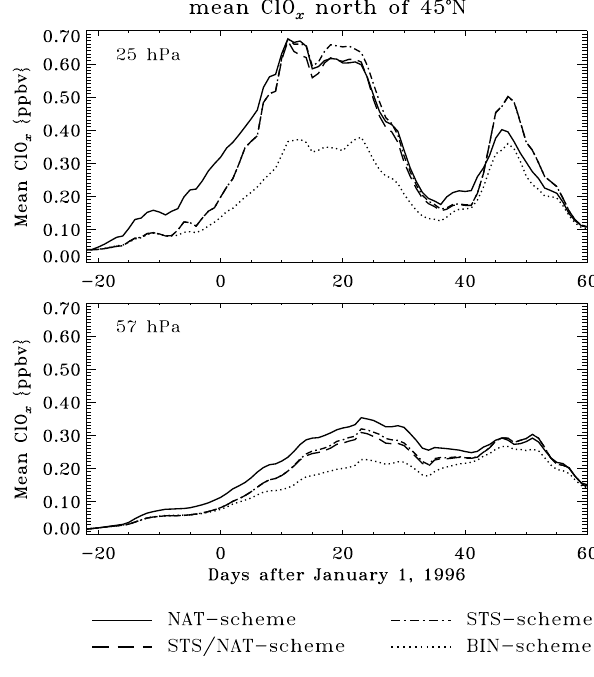
Fig. 5. Temporal change of the ClO mixing ratio (ppbv) averaged over the area between 45 ◦ N and 80 ◦ N. Model results are shown as obtained with the COMMA model applying the NAT-, the STS- and the STS/NAT-scheme, respectively. For comparison, correspond- ing average ClO concentrations derived from UARS-MLS observa- tional data as well as the potential MLS ClO errors are presented. Data is shown for the model levels (bottom frame) 57 hPa and (top frame) 25 hPa and the time period between 10 December 1995, and 29 February 1996. Only daytime ClO data is taken into account. See text for details.